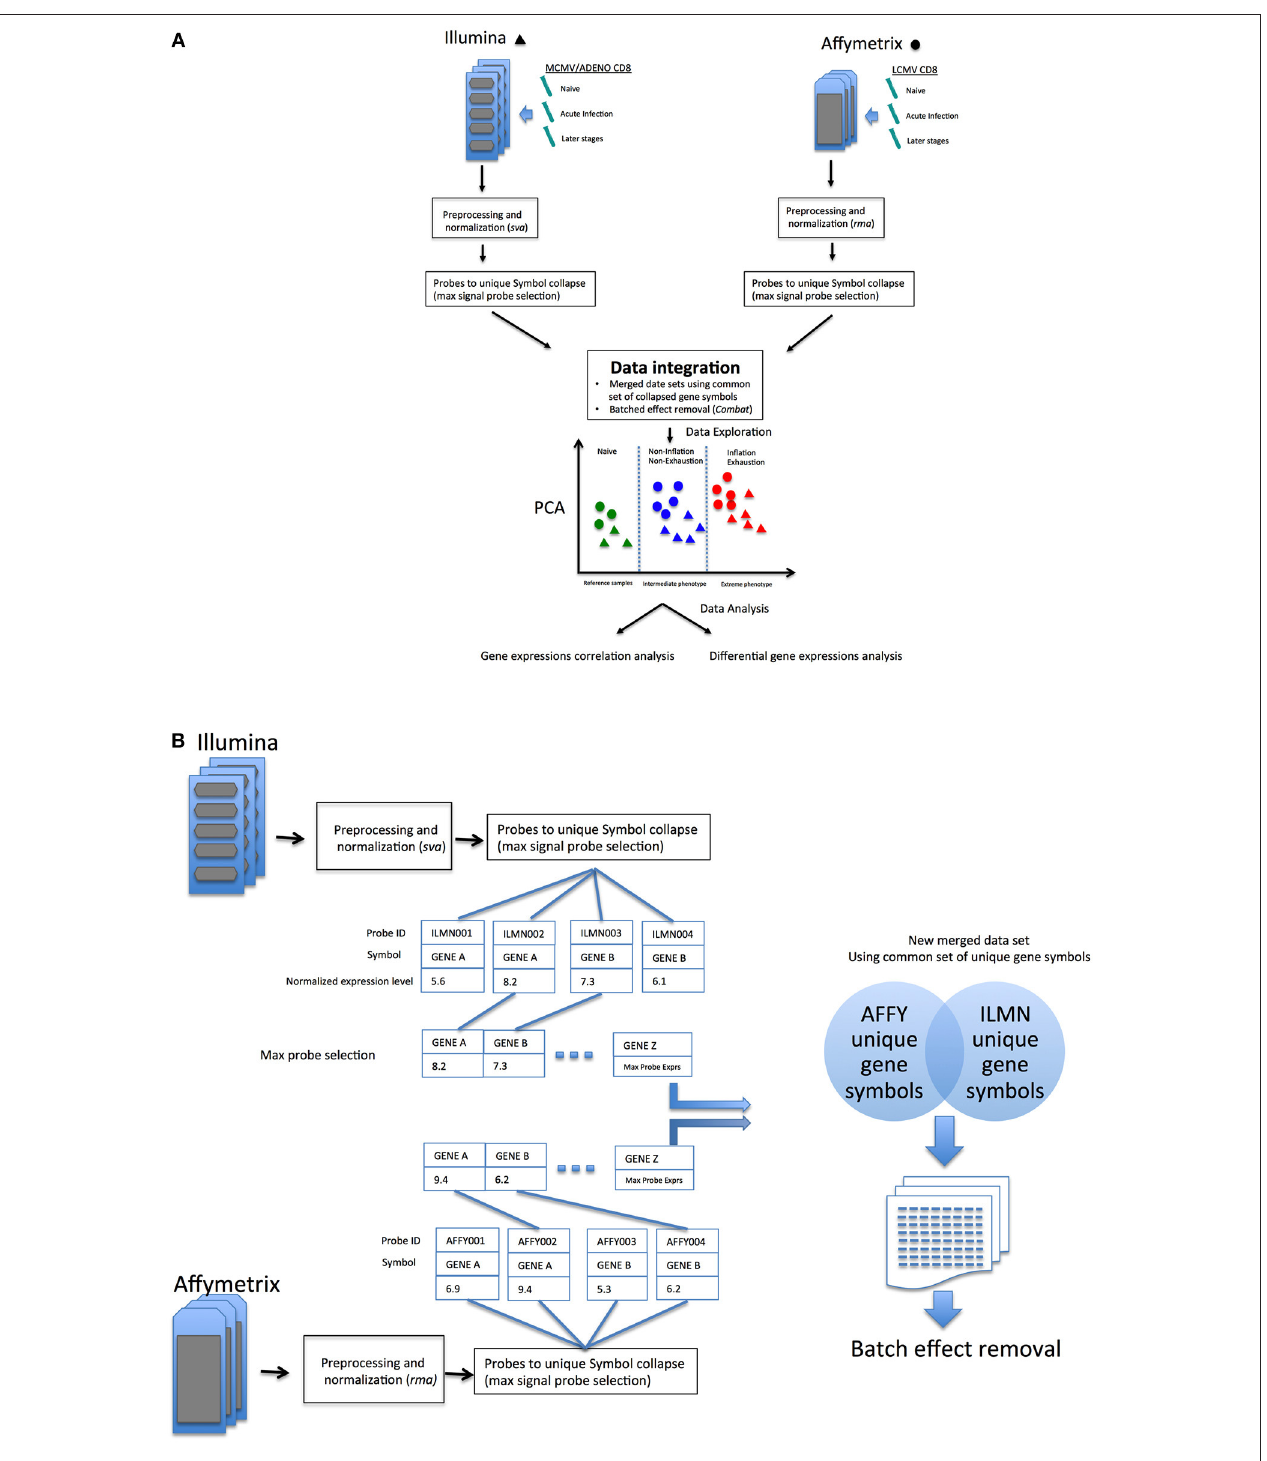
FIGURE 1 | (A) Overview of the data integration process and analysis. (B) Overview of probes-to-gene collapse method and data sets merge. reactivation while AdHu5 is a non-replicating vector which does not reactivate. Nonetheless the expression of both groups of conventional memory cells at the early phase of infection